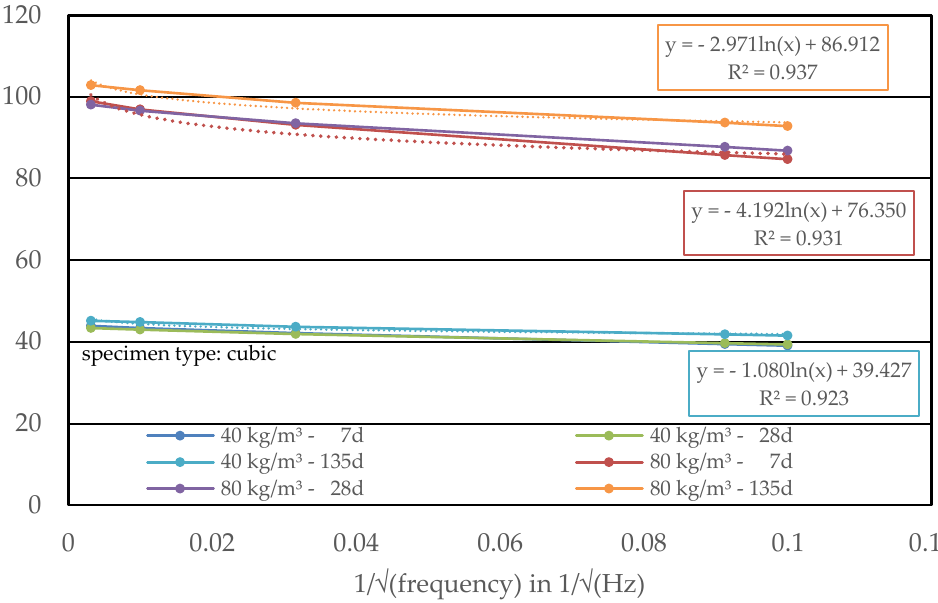
Figure 6. Calculated fibre content of the cubic specimens at varying frequencies of the alternating current depending on the age of the concrete and the actual fibre content of the samples (dotted lines represent the fitted trend lines according to the equations given in the corresponding graph).